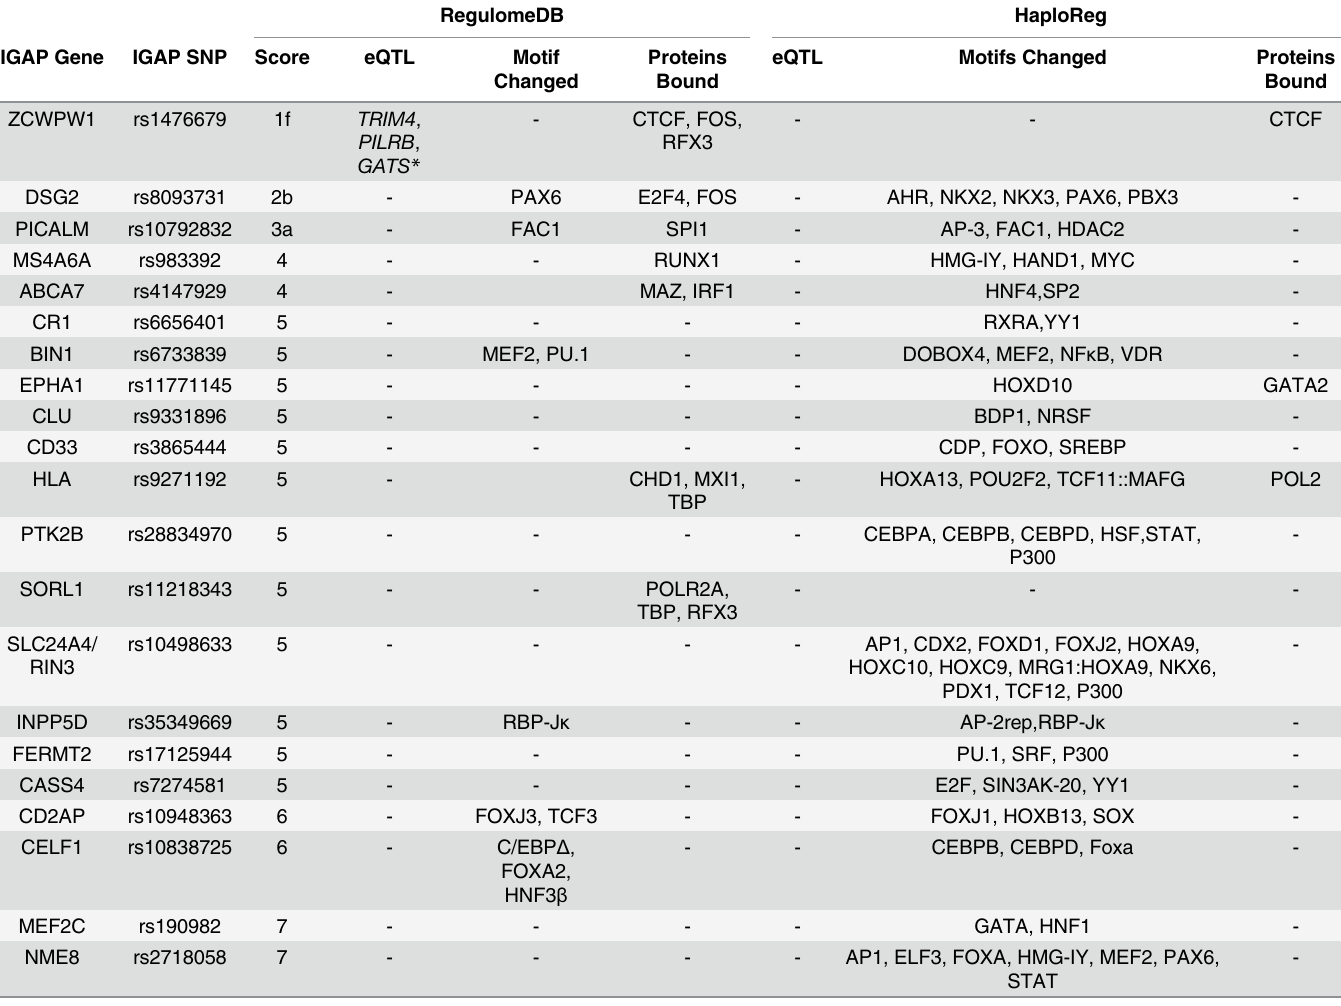
Table 1. Regulatory effects of IGAP top